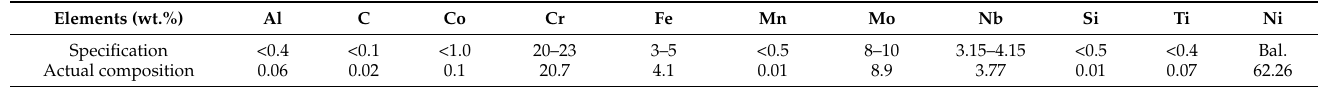
Table 1. Chemical composition of IN 625 metal powder (in